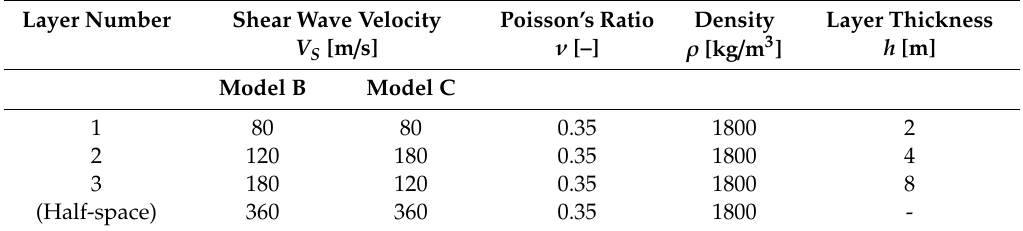
Table 2. Models B and C, four-layer models characterized by a gradual increase in shear wave velocity with depth [model B] and a sti ff er layer between two softer layers [model